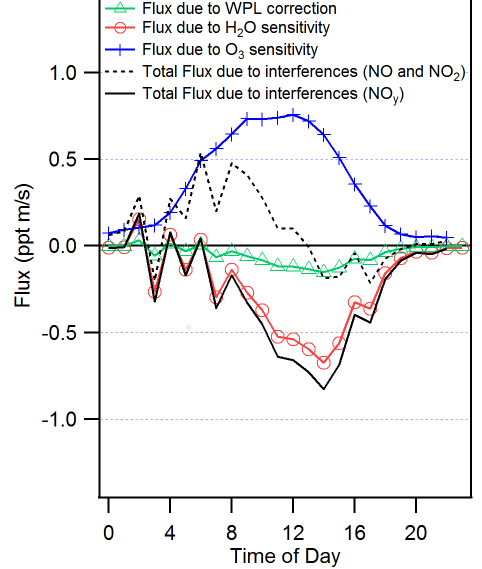
Fig. 3. Estimated flux interference terms due to water (WPL and chemiluminescent sensitivity) and ozone as a function of time of